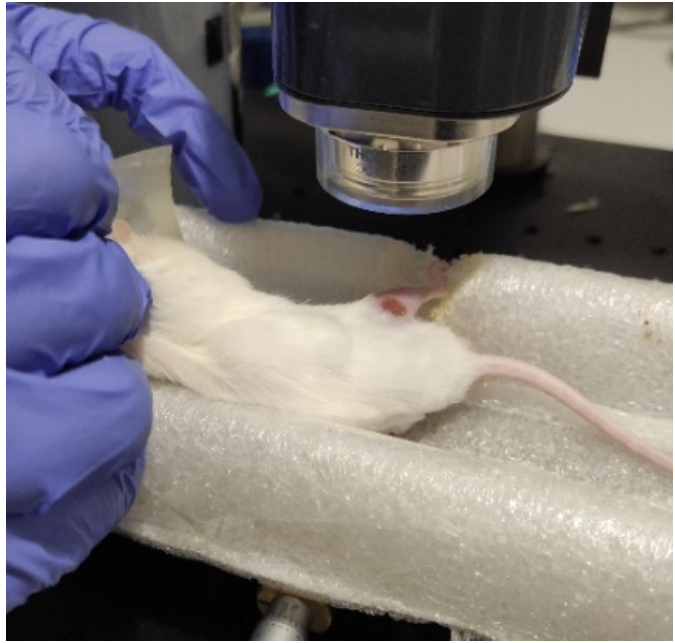
Figure 2. The mouse positioning during OCT imaging.